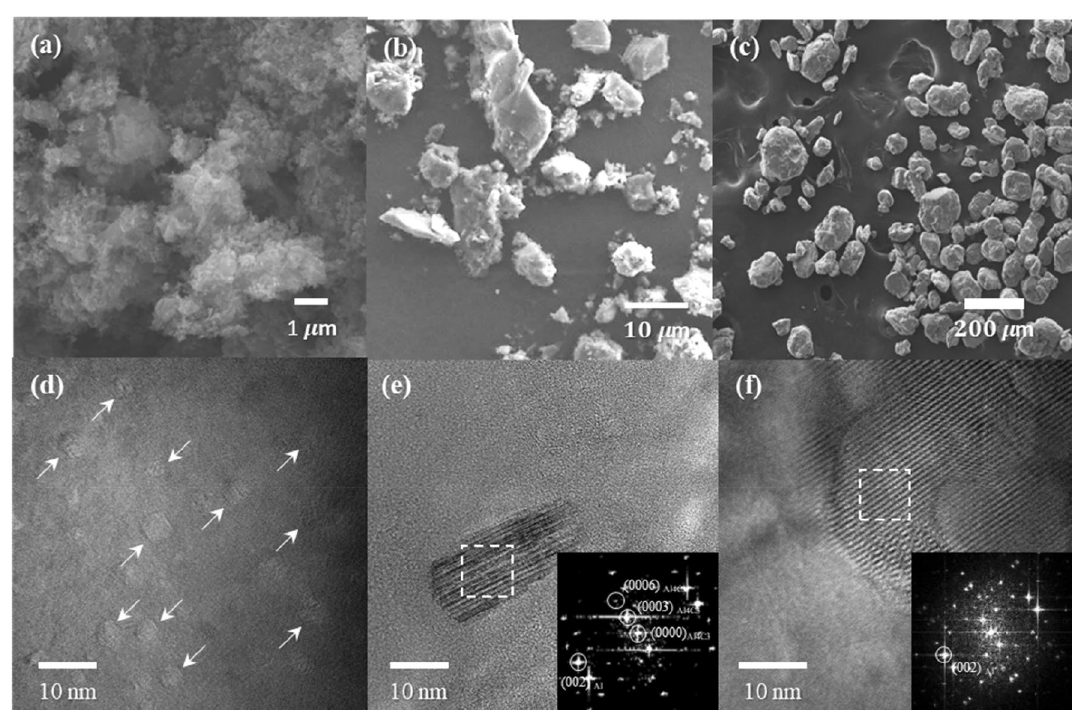
Figure 3. SEM images of ( a ) shattered fullerenes, ( b ) mixture of Al/fullerene powder, and ( c ) Al/fullerene composite powder, and TEM images of ( d ) fullerene dispersed in Al, ( e ) nano-sized Al carbide, and ( f ) Al-C phase. The inserted FFT patterns were obtained from the area marked by white